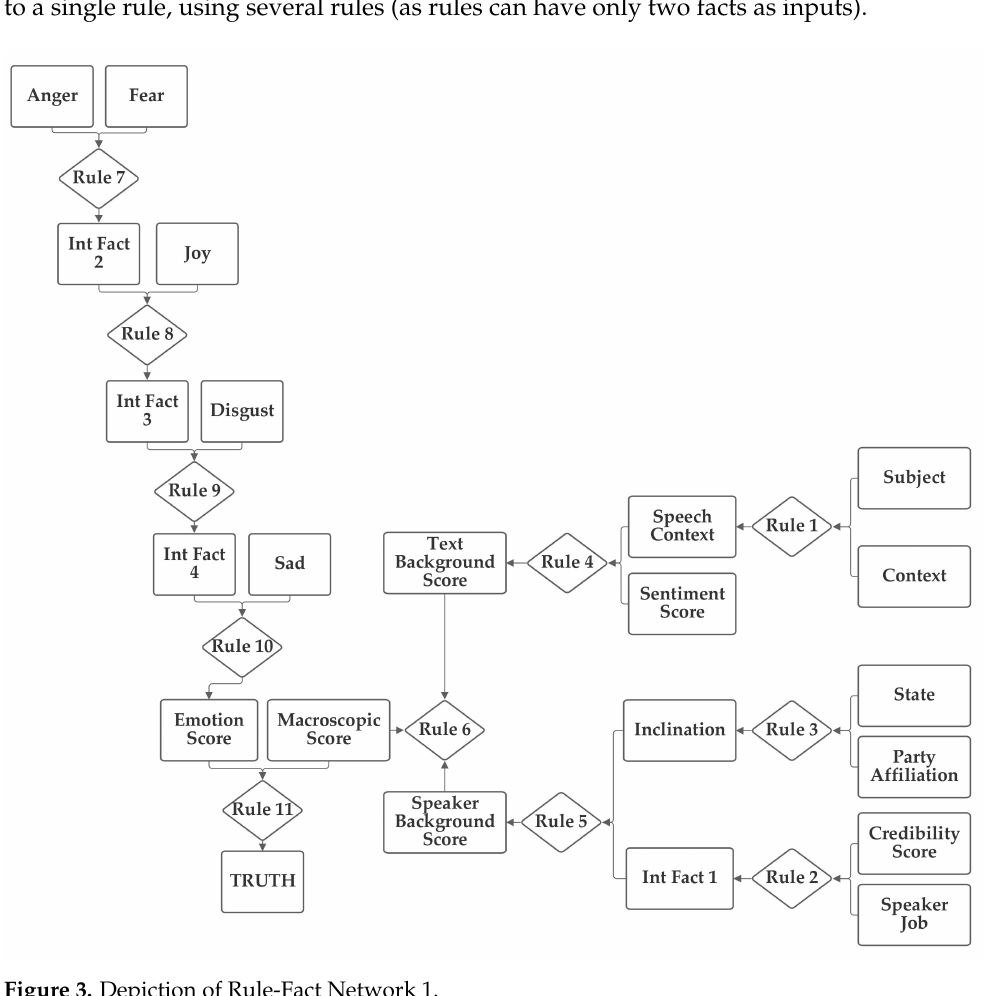
Figure 3. Depiction of Rule-Fact Network